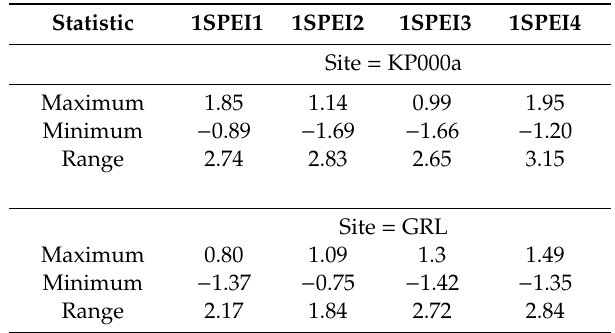
Table 8. Maximum, minimum, and range of 1 month timescale SPEI values 1SPEI1 through 1SPEI4 for sites KP000a and GRL. Statistic 1SPEI1